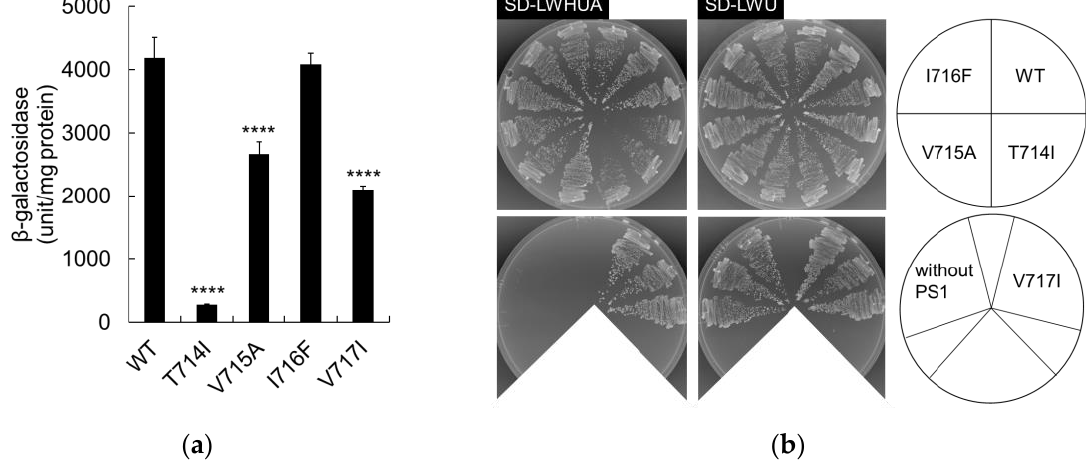
Figure 2. β-Galactosidase activity and growth of APP FAD mutants. Wild-type (WT) or FAD-mutant APPC55-Gal4p was introduced into yeast with PS1, NCT, Pen2, and Aph-1aL. Gal4p cleaved from APPC55-Gal4p activates the lacZ gene, which encodes β-galactosidase. ( a ) β-Galactosidase activity of APP FAD mutants. One unit of β-galactosidase activity corresponds to 1 nmol of O -nitrophenyl β-galactoside hydrolyzed per minute (expressed as units/mg lysate protein). Activity was normalized to control cells without PS1 (25 units/mg protein). Representative results from three independent assays are shown with standard deviations. Statistical analyses were performed by one-way analysis of variance (ANOVA) and Dunnett’s multiple comparison test. Asterisks indicate p < 0.0001 (****) compared to the WT; ( b ) The growth of cells expressing WT or FAD-mutant APP was examined after incubation at 30 °C for 3 days in selection media (SD-LWHUA). Three independent clones were evaluated for each strain. The growth of the mutants in medium containing histidine and adenine (SD-LWU) was comparable to that of the WT.